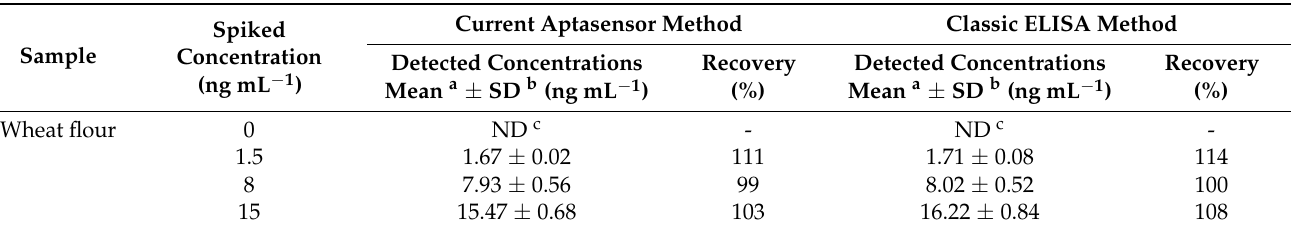
Table 2. Detection of FB 1 in the wheat flour samples.